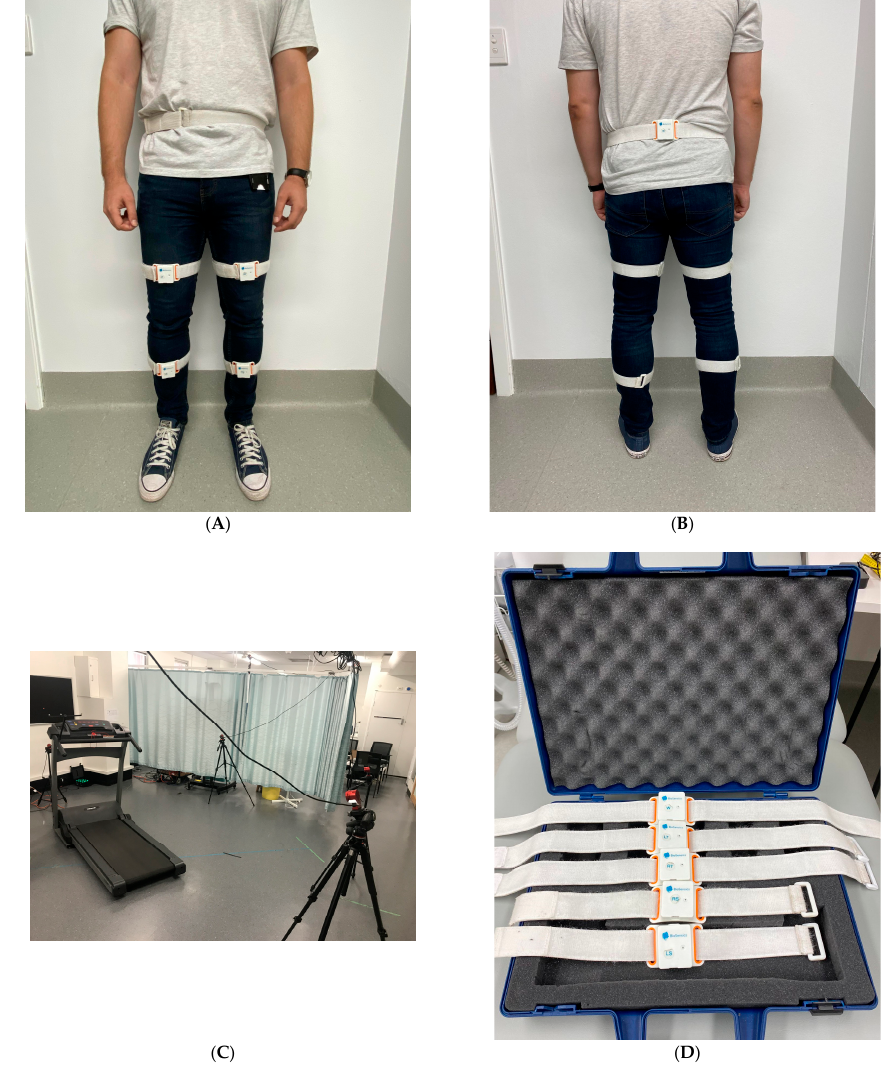
Figure 3 . The LEGSYS+ system. ( A , B ) show the LEGSYS+ system on a participant, with blue (leg), green (thigh) and orange (waist) being the standardised positions of each sensor. ( C ) Placement of the treadmill with the MOCAP system. ( D ) Storage box of the LEGSYS+ system with each of the 5 Bluetooth motion sensors on display. Stride Comparison between Systems The following gait parameters were extracted from the MOCAP data for comparison against LEGSYS as described in the LEGSys User Manual (stride time, stride length, stride velocity, cadence, left/right swing, left/right stance and left/right double support phase). All gait parameters were based on heel strike and toe off times. Using the MOCAP data, strides were determined using definitions for Heel strikes (HS) and toe-off (TO) using previously stated methods [46]. Briefly, left and right heel strikes were determined from the local minima of the respective mean heel cluster vertical axis position. Toe off was determined as the peak of the vertical velocity determined as the time differentiated mean vertical position of the respective cluster after heel strike. Then, left and right stride time was determined as the time in between consecutive heel strikes on the same side. Stride length was determined by multiplying stride time by the ‘actual’ treadmill speed. The remaining parameters (cadence, stride velocity, stance, swing and double support) were generated using the calculated stride time and length. At each treadmill speed, the last 20 complete stride cycles before the speed change were used (Figure 1). There might be a discrepancy between set and actual treadmill speed. To measure the actual treadmill speed, the average forward-backward position of the right heel cluster was filtered using a low-pass second order bi-directional Butterworth filter with a cut-off frequency at 5 Hz (bi-directional filter design reported) [47,48]. Then, mean position of the cluster was differentiated over time to determine velocity. A short time period of the for- ward backward cluster velocity from 0.25–0.42 s after each of the 20 included heel strikes was extracted. This time period coincided with the small part of the stance phase approx- imately in between the heel strike and consecutive toe-off. In this period the foot travels at the speed of the treadmill belt. Actual treadmill speed was then determined as the mean across all save time points.